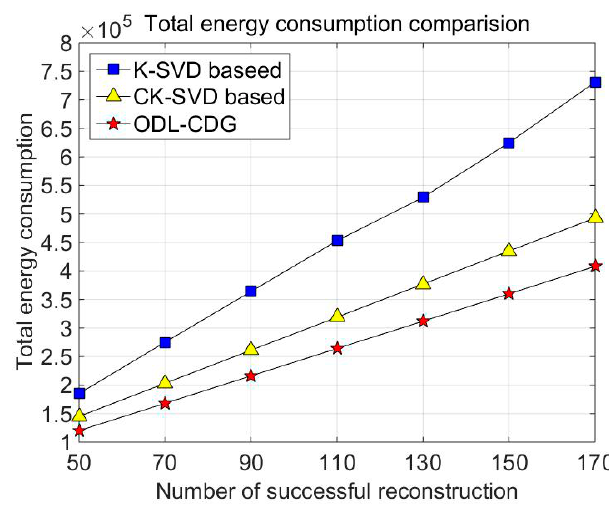
Figure 6. The total energy consumption of different dictionary learning based data gathering methods.